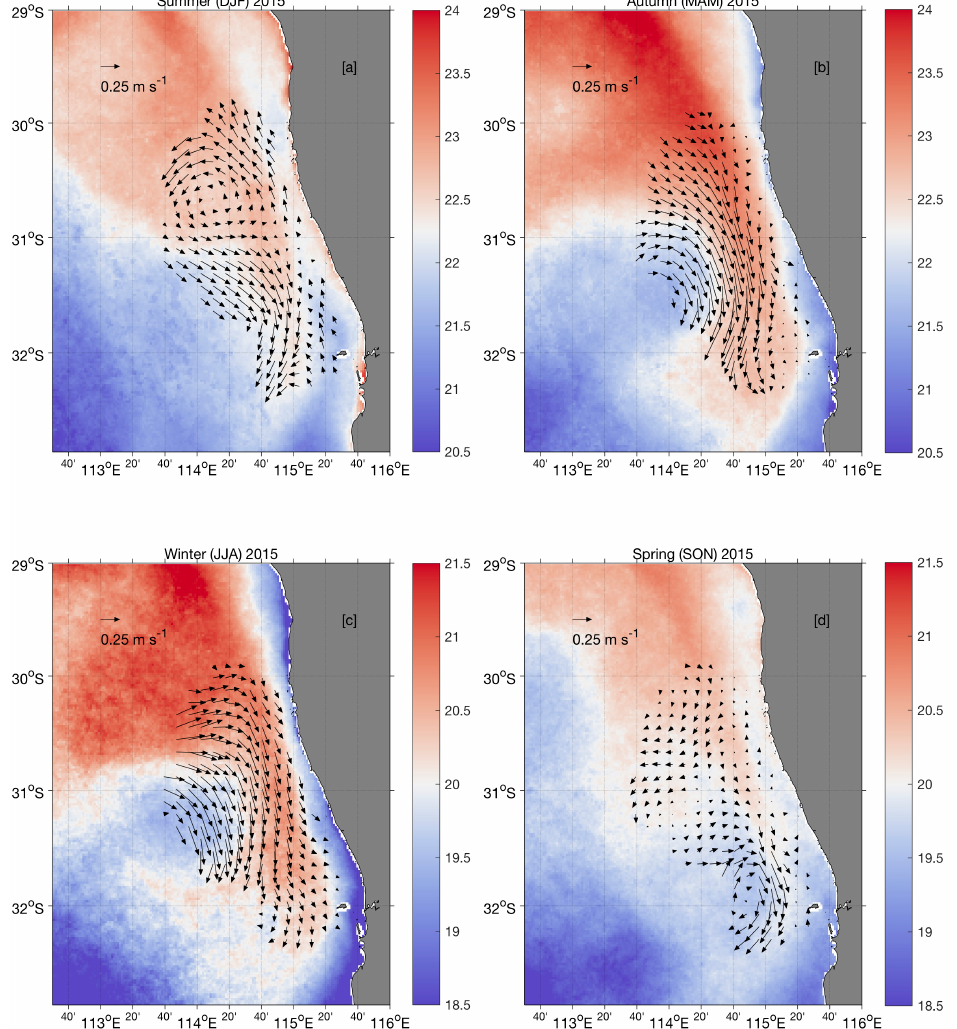
Figure 4. Seasonally-averaged HFR and SST data for 2015: ( a ) Summer (DJF); ( b ) Autumn (MAM); ( c ) Winter (JJA); ( d ) Spring (SON). Note changes in SST scale for summer / autumn ( a , b ) and winter / spring ( c , d ). Vector data have been subsampled every two grid point to increase readability. SST data originated from multi-sensor L3S foundation SST product.